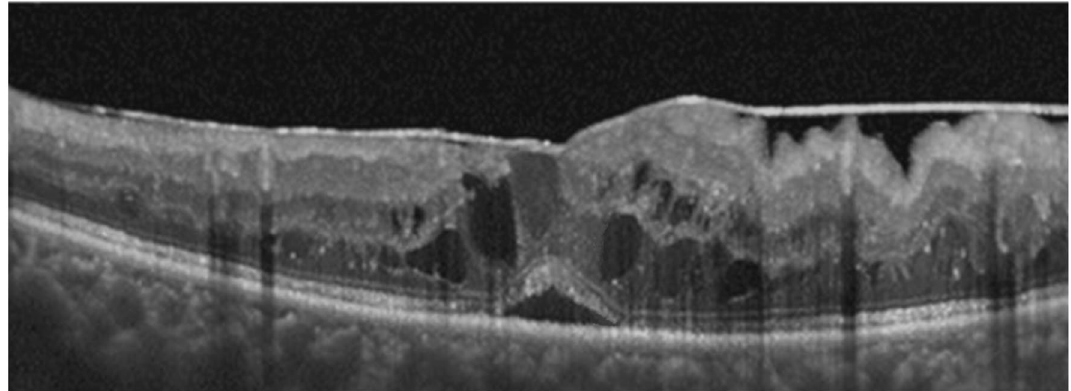
Figure 1. Optical coherence tomography scan showing tractional diabetic macular edema (tDME) with cystoid and retinal detachment pattern, and epiretinal membrane. A representative case.